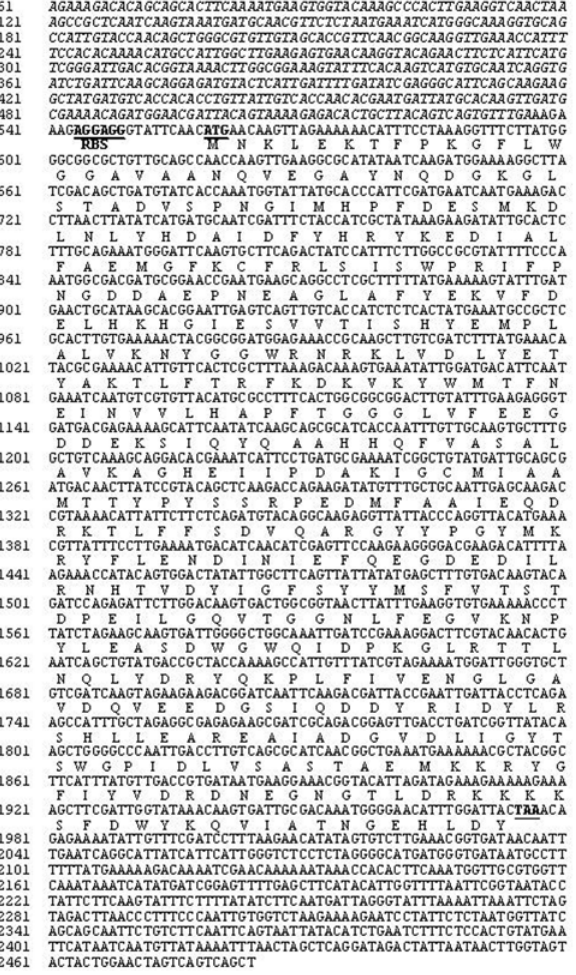
Figure 1 - Nucleotide sequence of the entire insert (2484 bp) and the de- duced protein sequence of the bglH gene from Bacillus pumilus. Start and stop codons and the ribosome-bounding site (RBS) are underlined. Partial nucleotide sequence of the bglP gene is in italic